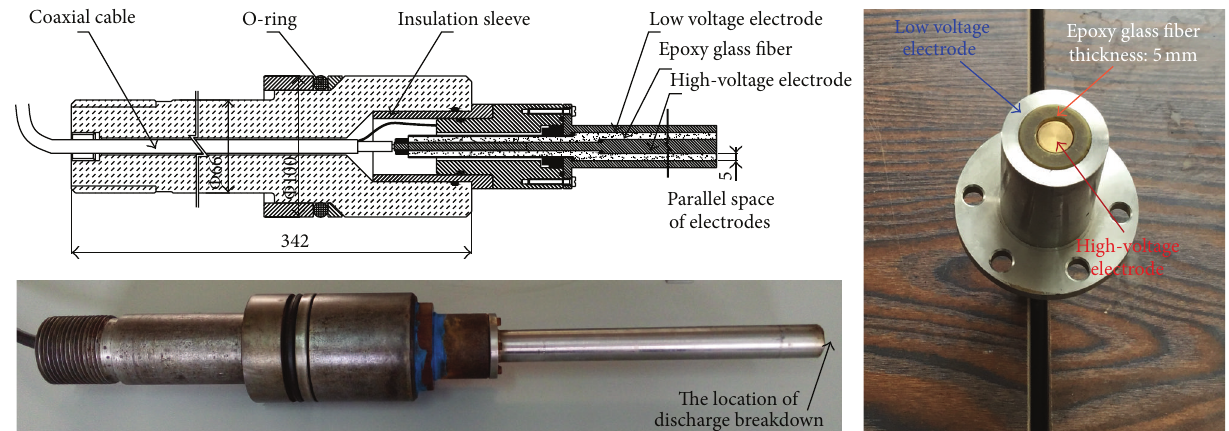
Figure 3: Schematic diagram and photograph of electrode